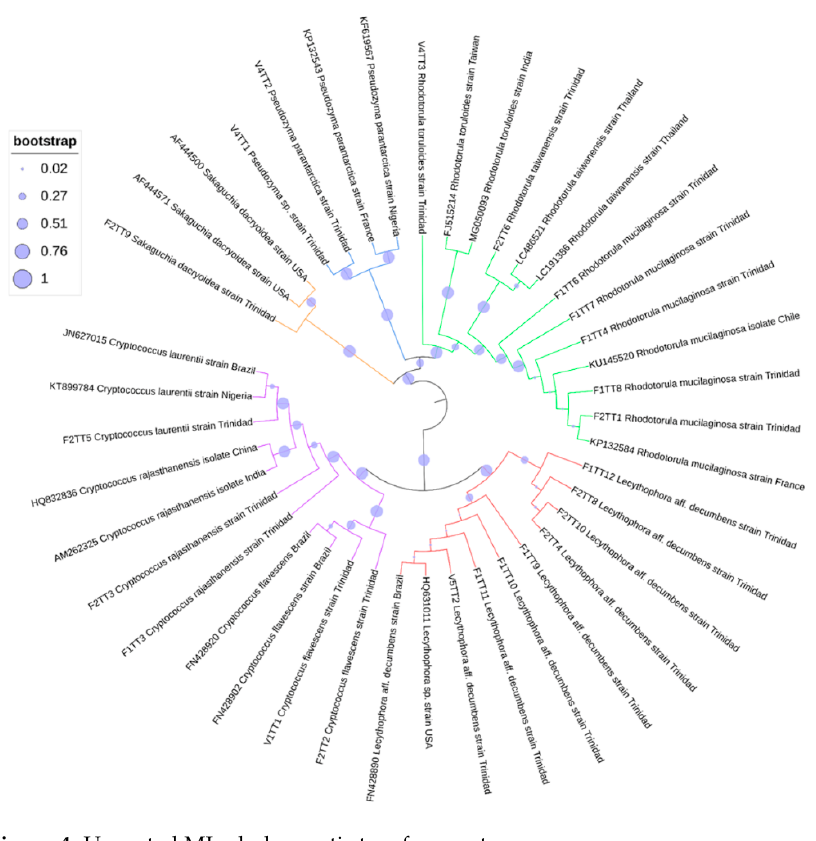
Figure 4. Unrooted ML phylogenetic tree for yeast.